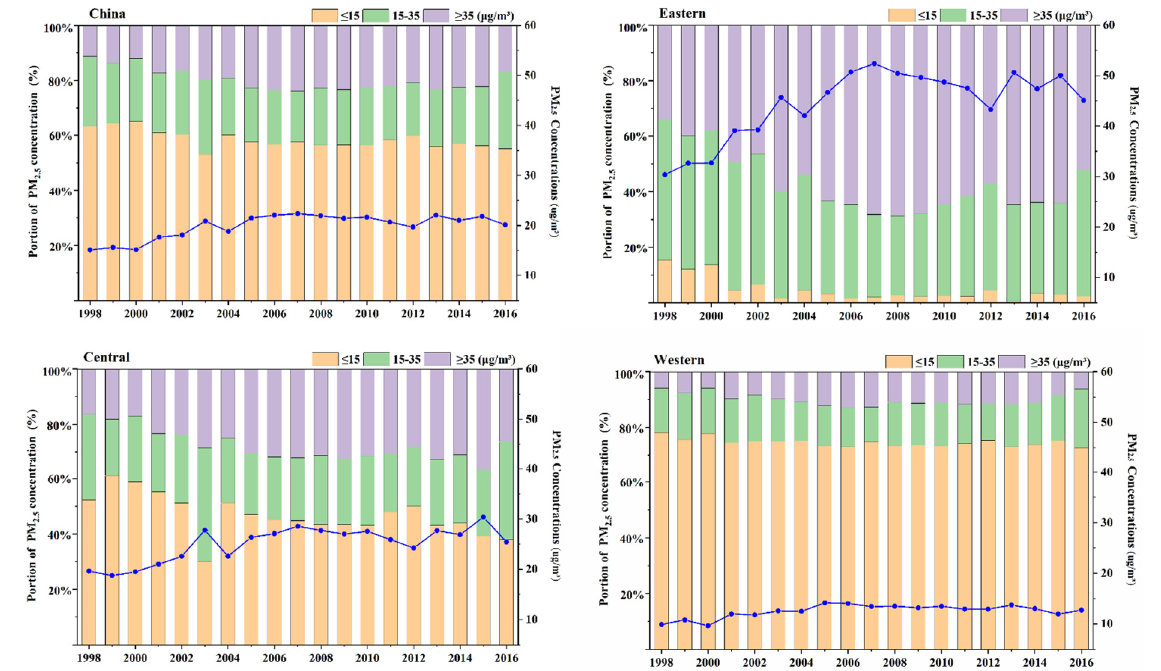
Figure 4. Changes in anthropogenic PM 2.5 concentrations by range in China during 1998–2016 (the blue line represents the average annual anthropogenic PM 2.5 concentrations of regions during 1998– 2016).